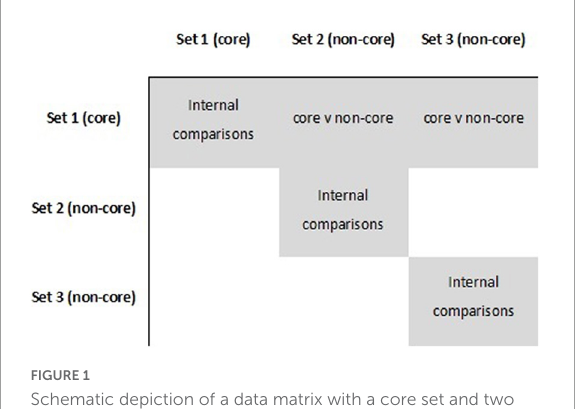
FIGURE1 Schematic depiction of a data matrix with a core set and two non-core sets.